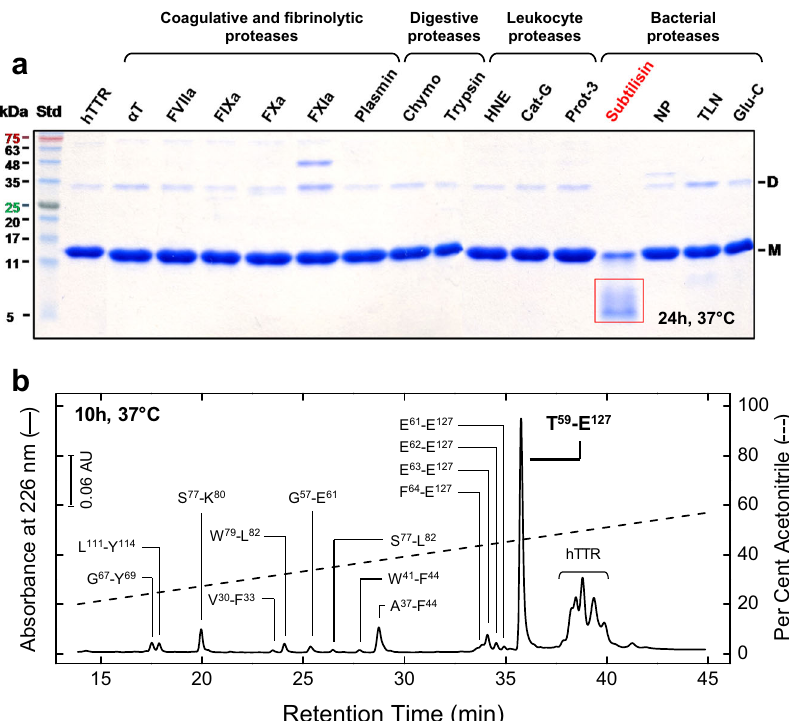
Fig. 1 Proteolysis of hTTR by different proteases. a hTTR (1 mg/ml) was reacted at 37 °C in TBS pH 7.4, containing 5 mM CaCl 2 , with different proteases at an enzyme:hTTR ratio of 1:20 (mol/mol): trypsin and chymotrypsin, α -thrombin ( α T), activated factors VII, IX, X, and XI, plasmin, human neutrophil elastase (HNE), cathepsin-G (Cat-G) and Proteinase-3 (Prot-3), subtilisin and neutral protease (NP) from Bacillus subtilis , thermolysin (TLN) from Bacillus thermoproteolyticus , and Glu-C speci fi c endoproteinase (Glu-C) from Staphylococcus aureus . After 24-h reaction, the proteolysis mixtures were analysed by reducing SDS-PAGE (4 – 15% acrylamide) and Coomassie stained. hTTR was resistant to all proteases tested, except to subtilisin (red). Gels bands corresponding to the monomeric (M) and dimeric form (D) of hTTR are indicated. Shallow bands at molecular weights higher than hTTR dimers are assigned to the proteases added. b RP-HPLC analysis of the proteolysis reaction of hTTR with subtilisin. The reaction was conducted as in a . After 10-h reaction, the proteolysis mixture was acid-quenched and fractionated on an analytical C18 column. Fractions were collected and analysed by high- resolution MS, allowing to establish the chemical identity of the peptide material eluted in correspondence of the chromatographic peaks. Small fragments were identi fi ed in most cases. Of note, the fragment eluting with the major chromatographic peak was identi fi ed as Thr59-Glu127 peptide (7757.4 Da) and was found to be resistant to further monomer (M) band strongly decreased along with that of the dimer (D), which was not detectable, whereas a diffused electrophoretic band appeared in the 5 – 9 kDa range. Besides subtilisin, only in the case of thermolysin a faint band at ~9 kDa was barely detectable while all other proteases failed to cleave hTTR. At variance with SDS-PAGE, the corresponding native PAGE analysis of the proteolysis reaction of hTTR with subtilisin was not very informative, as the newly generated fragment and the residual parent protein co-migrated in a single/diffused band (Supplemen- tary Fig. 3). Indeed, despite the different molecular weight (MW) and isoelectric point (pI) of hTTR(59 – 127) [MW = 7757 Da, pI = 4.95] and hTTR [MW = 13,761 Da, pI = 5.31], they accidentally share a similar charge/size ratio and thus similar electrophoretic